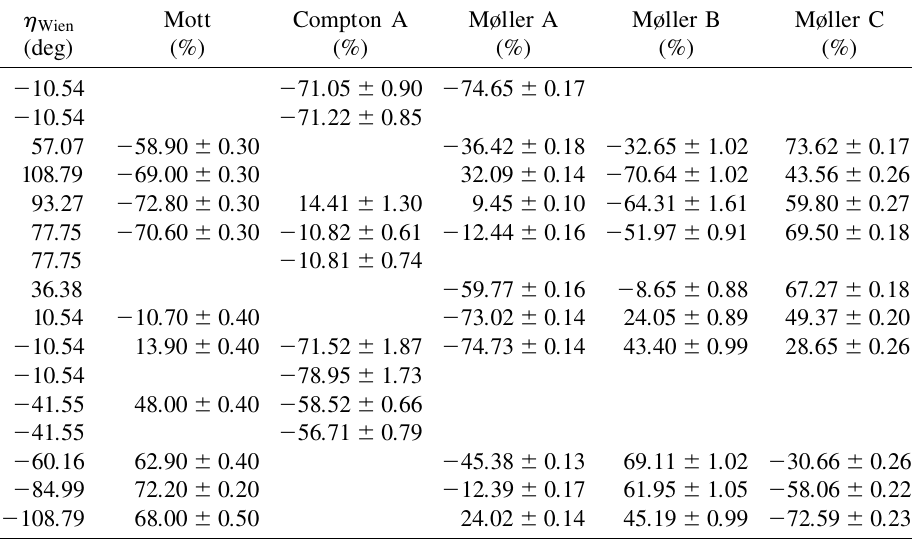
TABLE II. Summary of polarization measurements, using the effective analyzing power quoted for each polarimeter. All measurements were made using the dc laser mode except for the Compton measurements which all used the rf laser mode. The uncertainties below are statistical